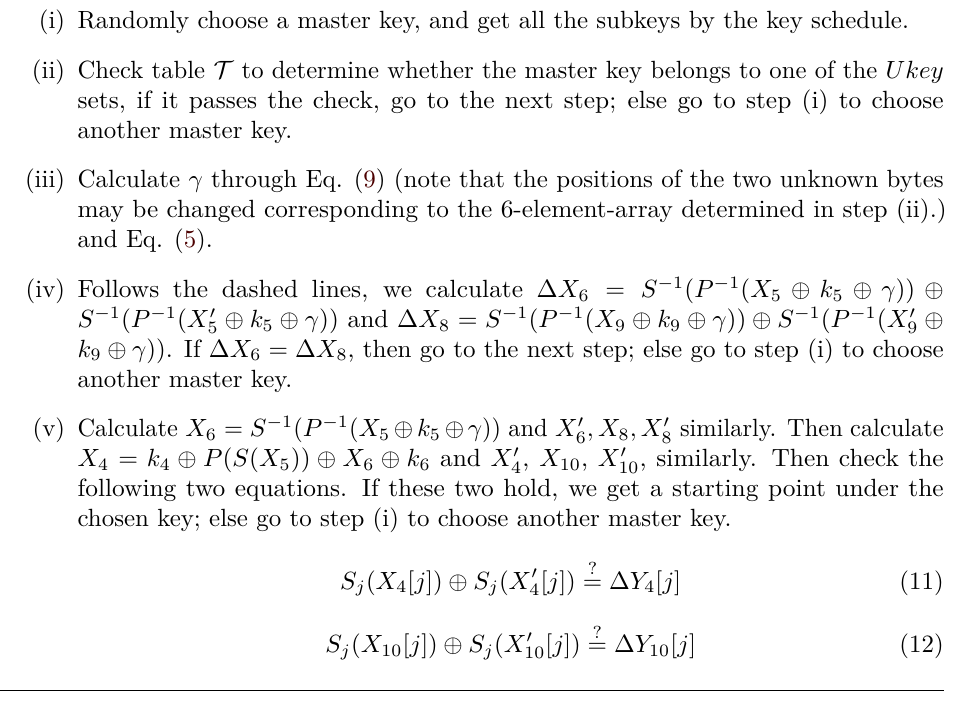
Algorithm 1 Calculate Starting Point by the 7-round Inbound